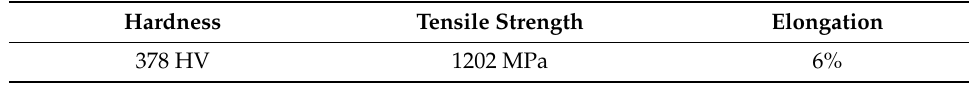
Table 3. Mechanical properties of SS 304 (JIS G4313).